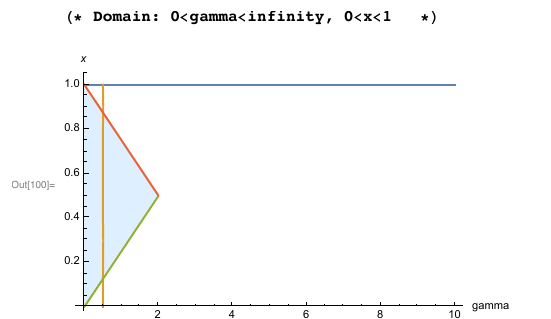
Figure 5. Normal solution g ( γ = 0 . 17 , x ) of eq. 10 with the kernel (11) vs. x = 1 parameters m = 1, µ = 0 . 15, B = 0 . 1, α = 1 . 4375 for fixed value γ = 0 . 17